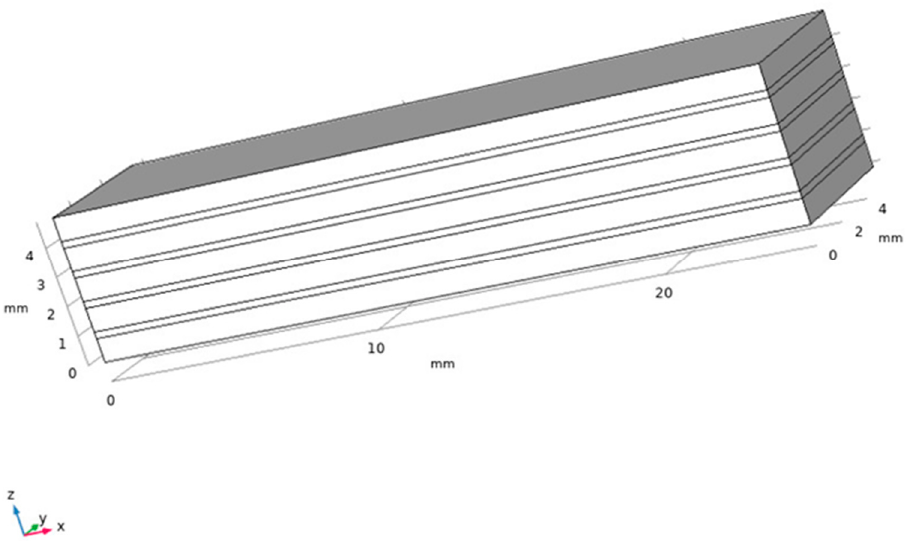
Figure 12. Geometric model of the four-layer EC heat pump.